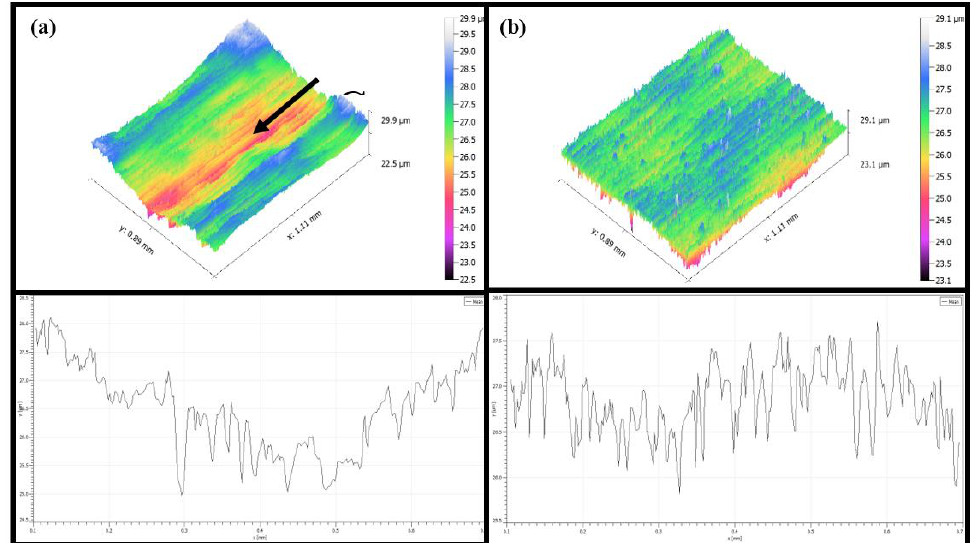
Figure 13. ( a ) Shows the surface of test 1, and ( b ) shows the surface of test